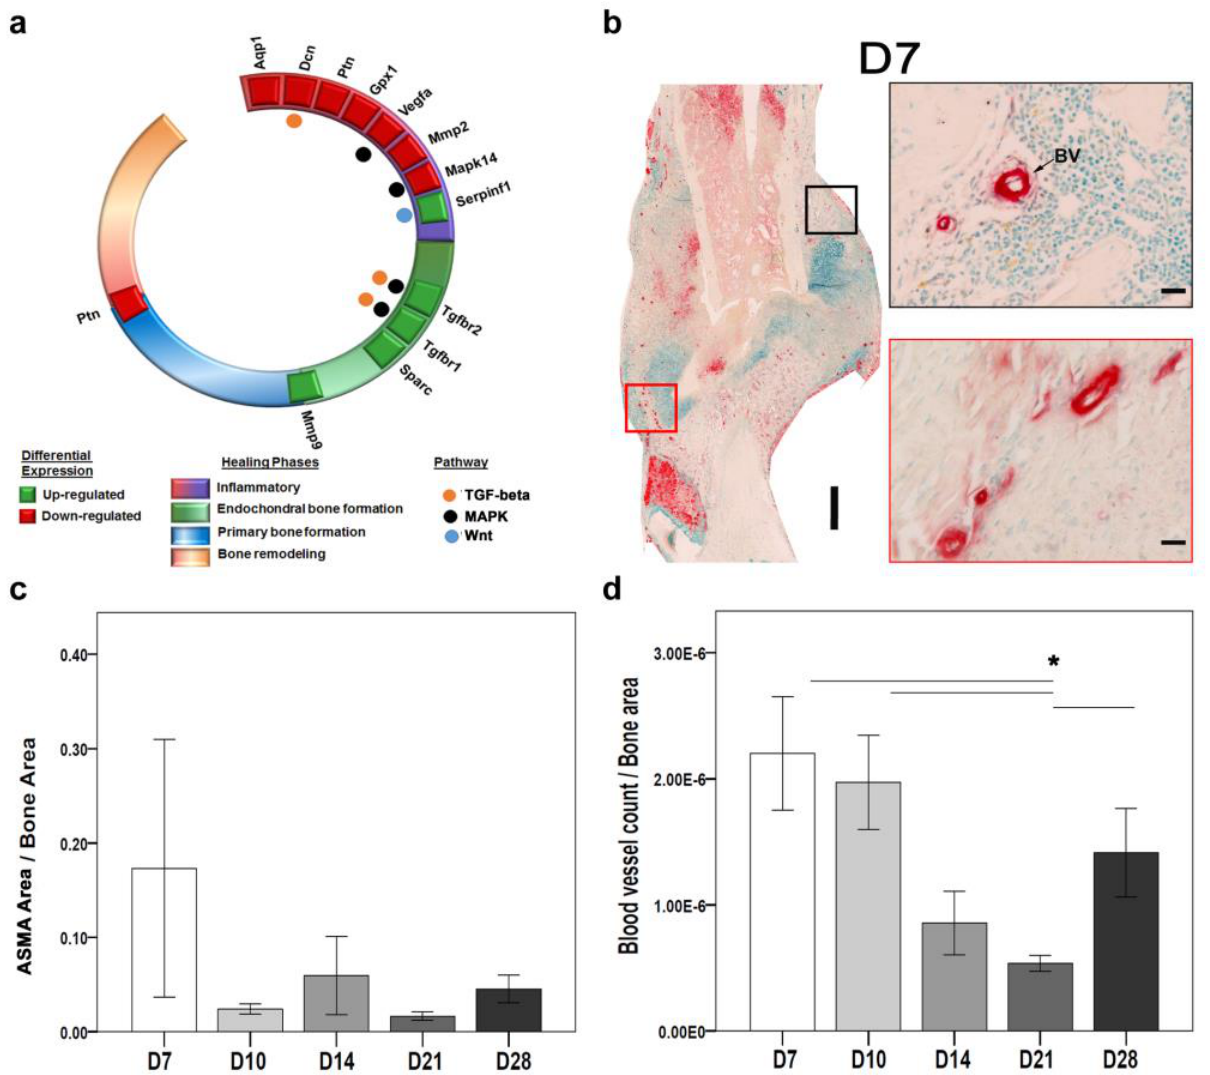
Figure 3. Early inflammatory phase correlates with angiogenesis at both the molecular and cellular level in wild-type mouse. ( a ) Differential gene expression analysis showed that a higher number of angiogenesis genes were downregulated during the inflammatory phase. ( b ) ASMA-positive–stained regions were seen around the fractured gap most abundantly at D7. ( c ) Quantitative analysis showed the highest ASMA-positive area at D7 and the lowest at D21. ( d ) Significantly lower blood vessel counts at D21 compared with all other time points. (N: D7 = 4, D10 = 6, D14 = 3, D21, D28 = 5; nonparametric distribution, Mann-Whitney U-test, * = p ≤ 0.05, red and black boxes represent higher magnification, BV: blood vessels, scale bar: ( b left panel): 250 µ m, ( b right panel): 25 µ m)). Histomorphometry showed a higher ASMA-stained area at D7 compared with other time points (Figure 3b,c). The blood vessel count was significantly higher at D7 and significantly lower at D21 (Figure 3d). The higher ASMA activity correlates with the angiogenesis-related gene expression at early time points. At the molecular level, the Asma gene was not significantly